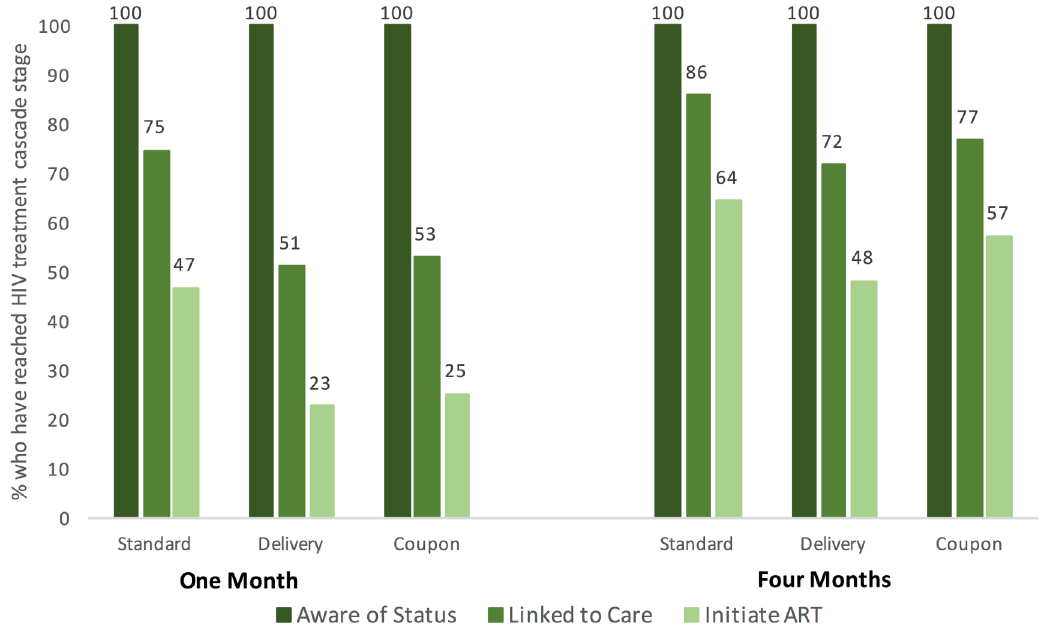
Fig 2. HIV care cascade among women who self-reported a positive HIV status at 1 and 4 months after randomization. Note that by definition all women are aware of their status, as this figure is restricted to women who self- reportedhavingtested positive for